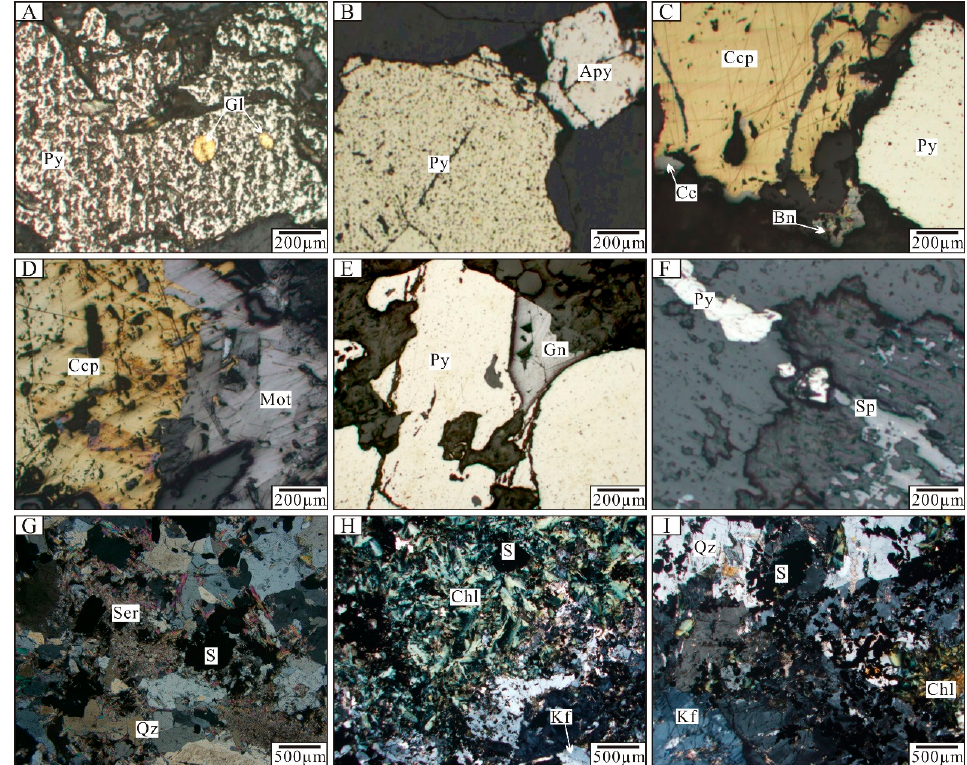
Figure 5. Photomicrographs of key mineral assemblages in the Jinchang Deposit. ( A ) Native gold in pyrite; ( B ) coexisting pyrite and arsenopyrite; ( C ) pyrite–chalcopyrite–chalcocite–bornite assemblage; ( D ) chalcopyrite–molybdenite assemblage; ( E ) coexisting pyrite and galena; ( F ) pyrite–sphalerite veinlet; ( G ) beresitization of the wall-rock; ( H , I ) chloritization and K-feldspar alteration of wall-rock. Abbreviations: Qz, quartz; Ser, sericite; Chl, chlorite; Kf, K-feldspar; S, sulfide; Py, pyrite; Ccp, chalcopyrite; Gn, galena; Sp, sphalerite; Apy, arsenopyrite; Mot, molybdenite; Bn, bornite; Cc,